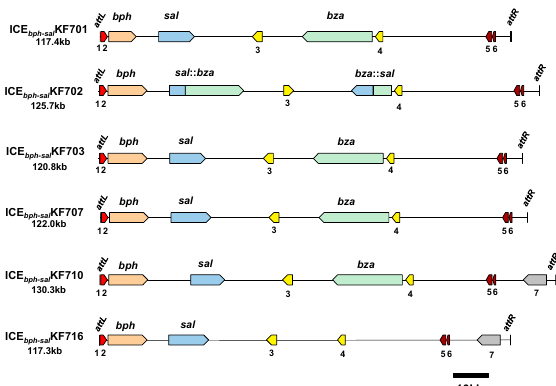
Figure 6. Organization of the ICE bph-sal in KF strains of group I and KF701 of group II. ICE bph-sal KF701, ICE bph-sal KF702, ICE bph-sal KF703, ICE bph-sal KF707, and ICE bph-sal KF710 carry the int gene, bph genes, sal genes, and bza genes. ICE bph-sal KF716 carries the int gene, bph , and sal genes, but not the bza genes. The sal genes and bza genes in ICE bph-sal KF702 are recombined. 1, tRNA-Gly(CCC) genes (partial); 2, int genes; 3, VirB4 components of the type IV secretory pathway; 4, VirD4 component of the type IV secretory pathway; 5, parB genes; 6, parA genes; and 7, putative multidrug efflux pumps. The other, undefined gene components are not shown in the figure.